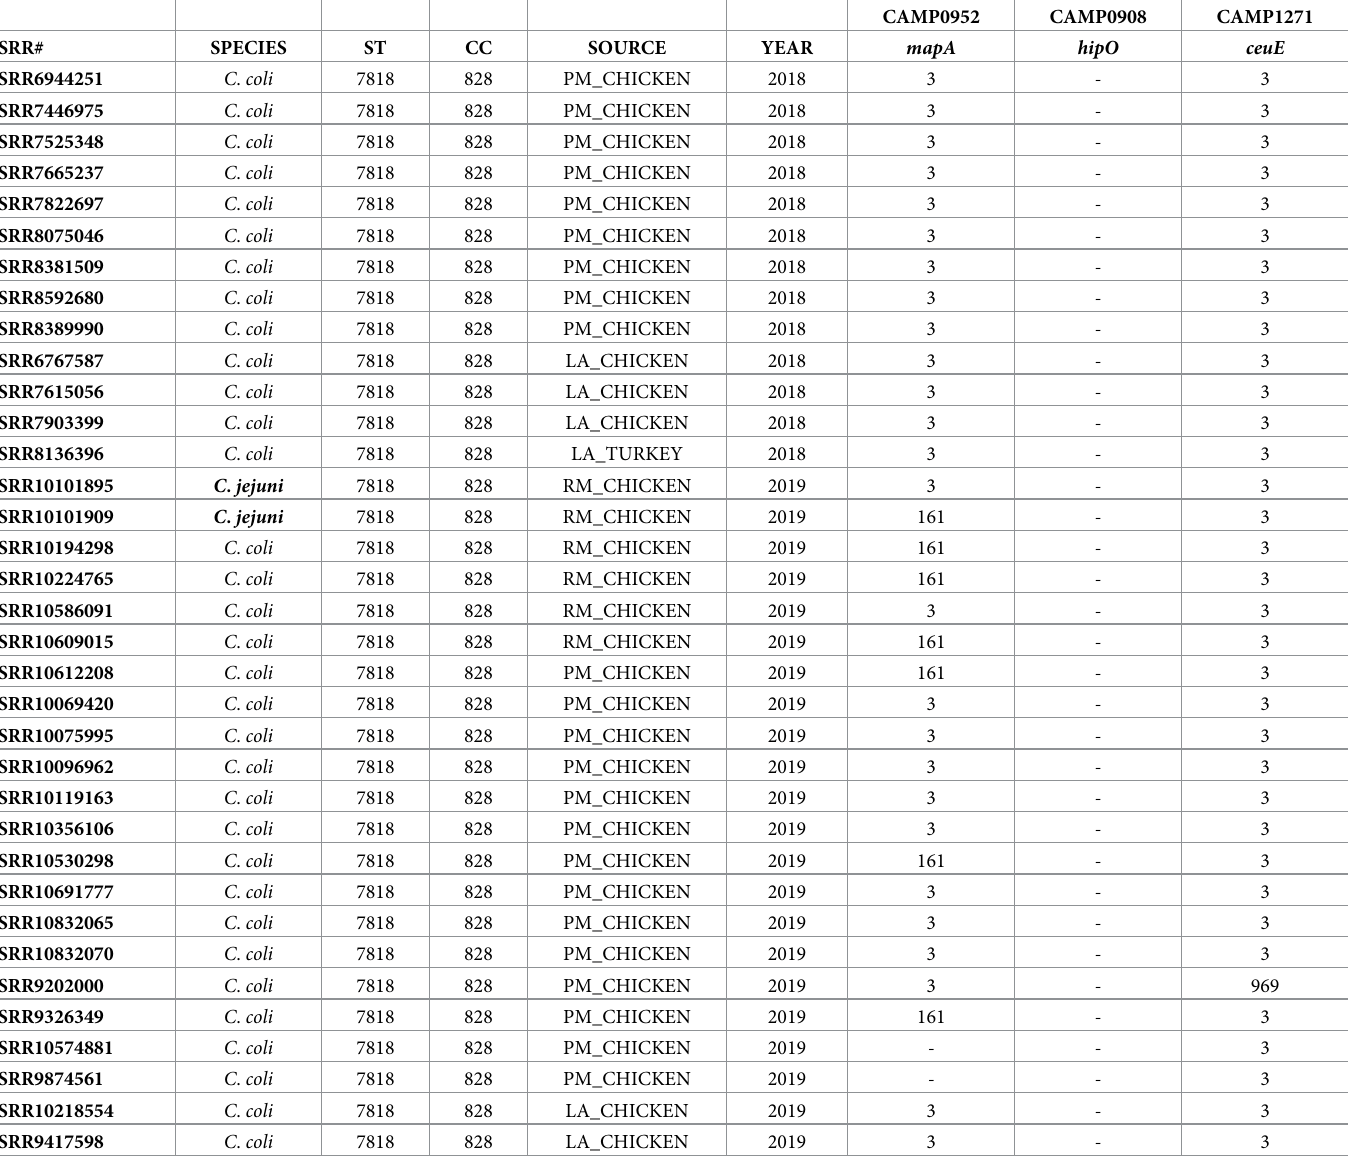
Table 2. ST 7818 Campylobacter housekeeping allele MLST ST species crossover and allele matches for C . Jejuni and C . coli species specific genetic